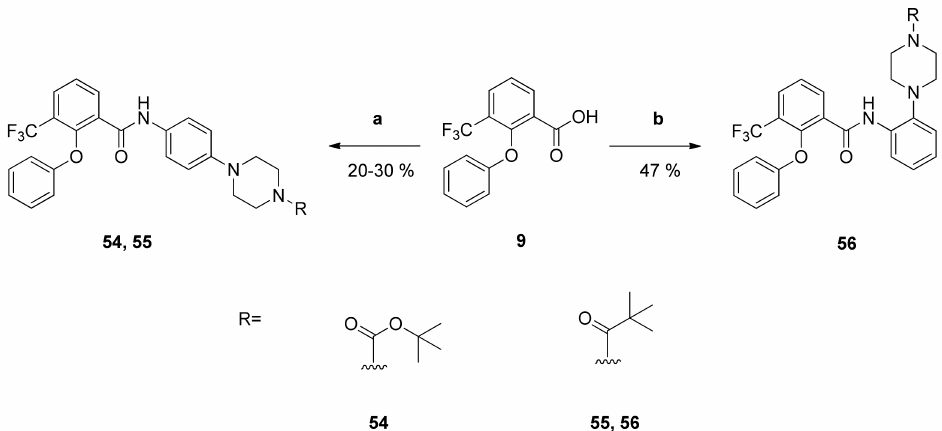
Figure 7. Preparation of compounds 54 – 56 . Reagents and conditions: ( a ) (1) 48 or 49 , CH 2 Cl 2 , 0 ◦ C, 5 min; (2) 2-chloro- N - methylpyridinium iodide, DIPEA, rt, 24 h; ( b ) (1) 25 , CH 2 Cl 2 , 0 ◦ C, 5 min; (2) 2-chloro- N -methylpyridinium iodide, DIPEA, rt, 24